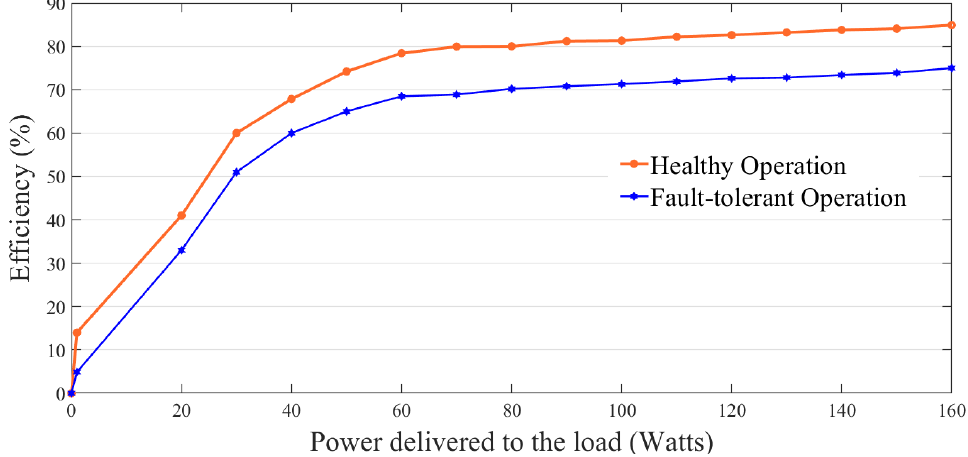
Figure 17. Efficiency